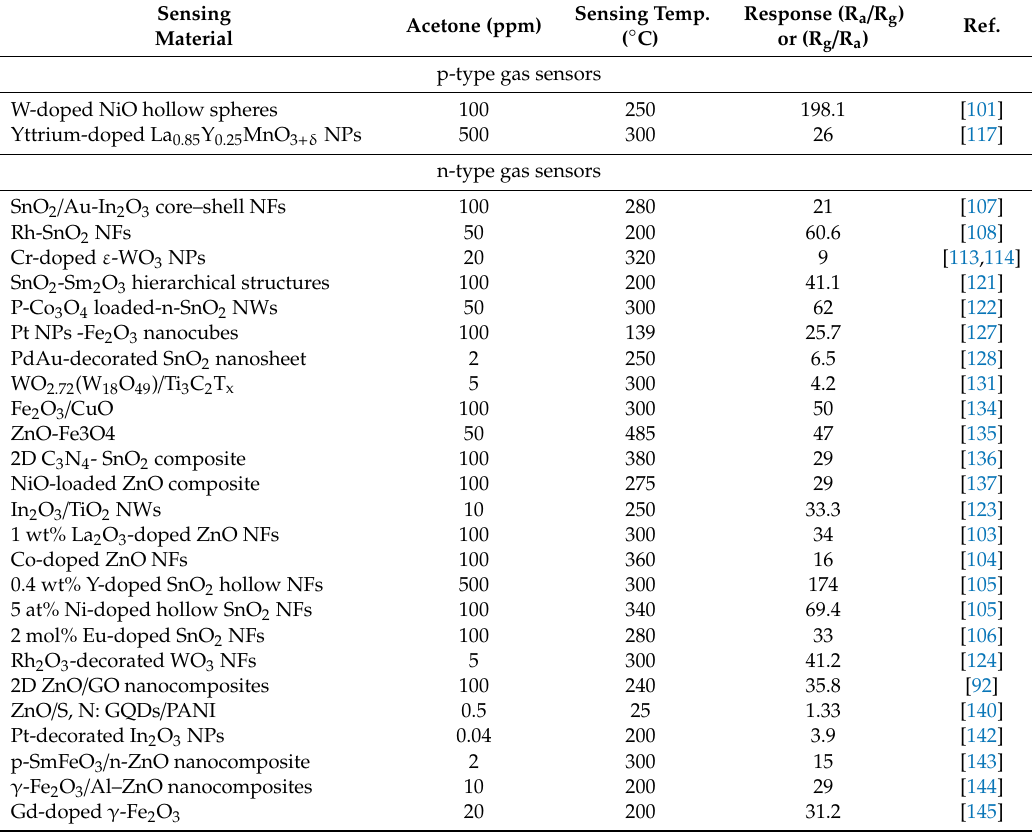
Table 2. A summary of decorated / loaded / composites acetone gas sensors reported in the